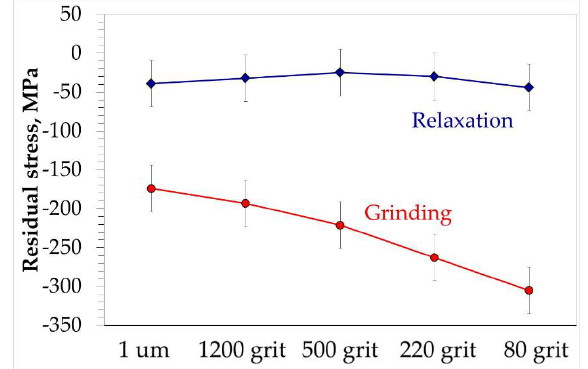
Figure 13. Plot showing measured residual stresses on Ni-14Cr-4Al samples at stage after relaxation heat-treatment and after different mechanical surface preparation method.